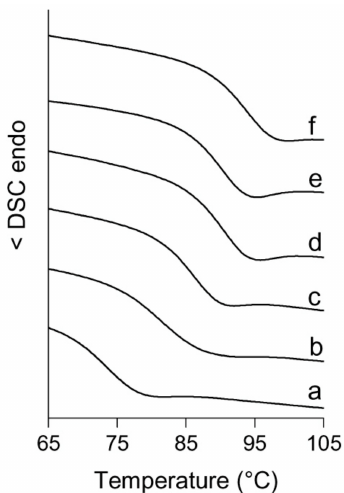
Figure 3. DSC curves (second heating) of E / NB copolymers obtained with (a) VCl 3 (THF) 3 (entry 12, NB = 41.2 mol%), (b) 1c (entry 9, NB = 38.7 mol%), (c) 1e (entry 11, NB = 38.8 mol%), (d) 1a (entry 7, NB = 38.0 mol%), (e) 1b (entry 8, NB = 37.8 mol%) and (f) 1d (entry 10, NB = 39.3